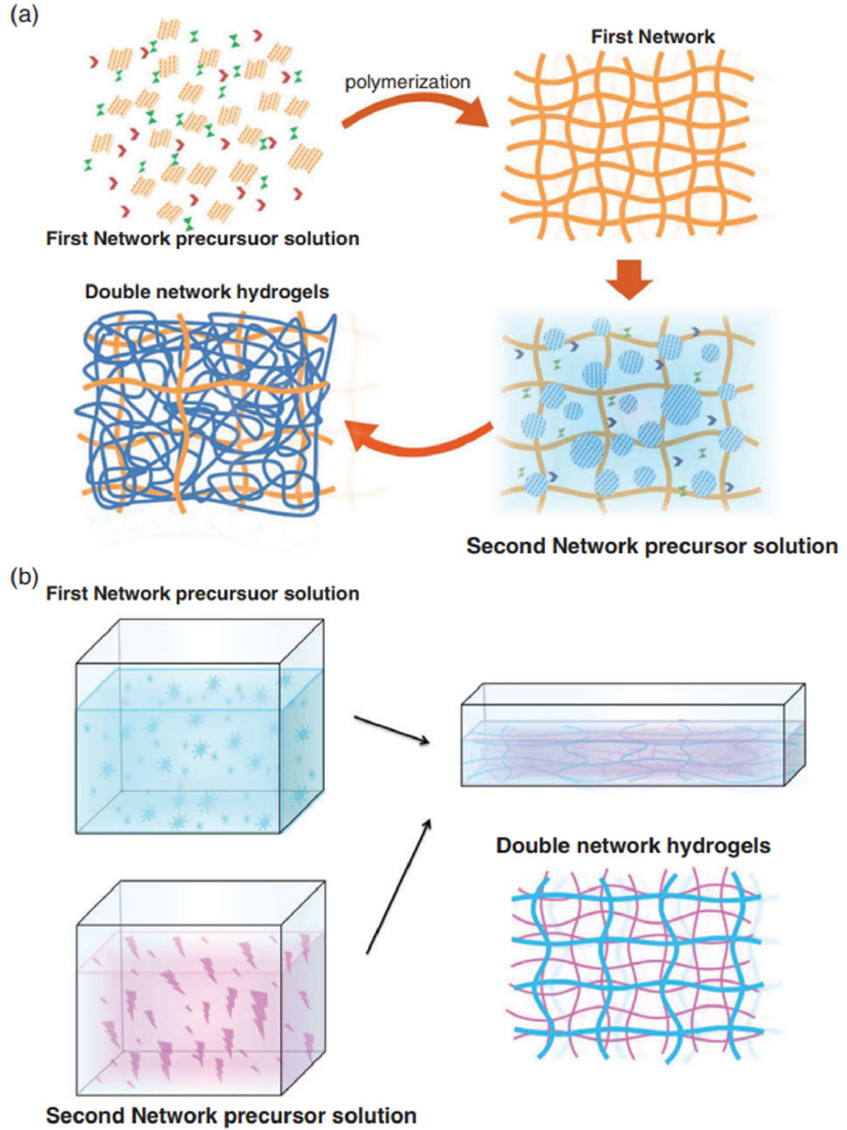
Figure 2. Schematic illustration of the preparation of DN hydrogels by chemically-chemically crosslinking. ( a ) Two-step polymerization method and ( b ) molecular stent method. Reprinted with permission from Ref. [145]. 2018, Wiley Periodicals, Inc.